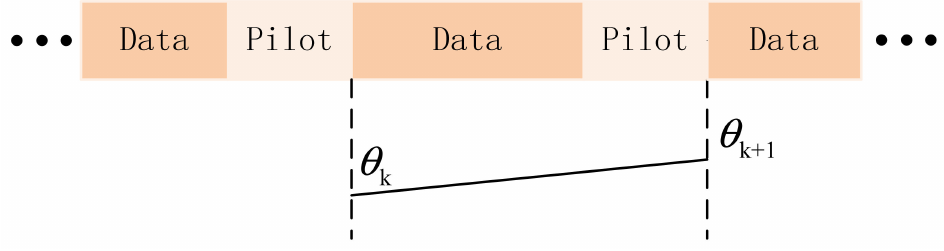
Figure 7. Pilot-aided (PA) phase linear interpolator.